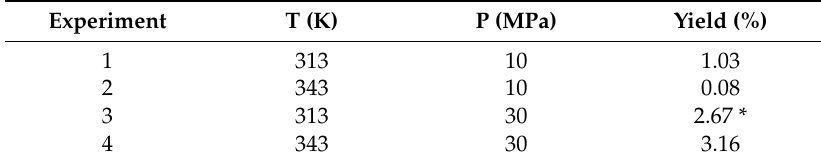
Table 1. SFE of Vaccinium meridionale Swartz (Mortiño). Extraction cell capacity = 273 cm 3 (0.160 kg